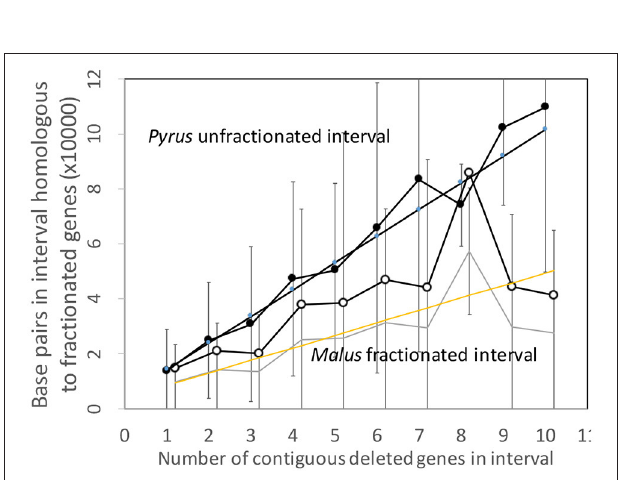
FIGURE 8 | Comparison of DNA content in conserved and reduced intervals in the Pyrus and normalized Malus genomes.